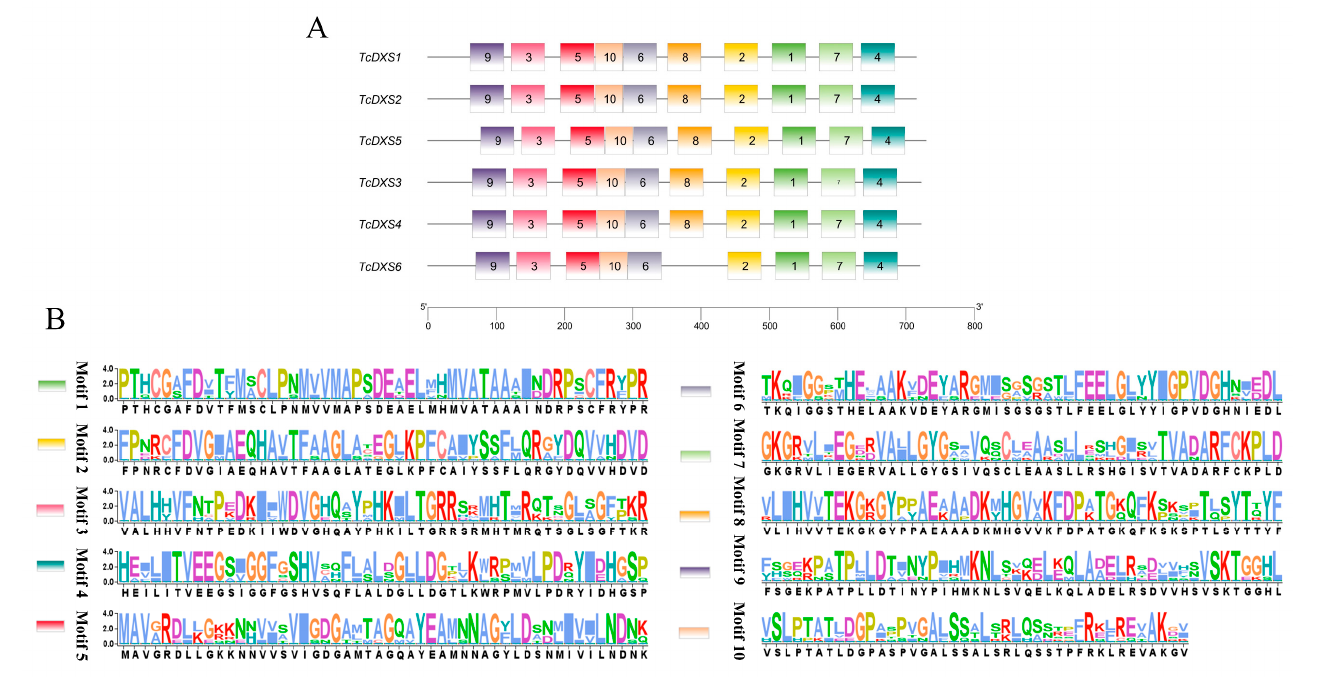
Figure 4. Motifs of TcDXS proteins. ( A ) Analysis of the motifs of TcDXS proteins by MEME. ( B ) Different colors represent different motifs, and the motif sequence is shown in the figure.